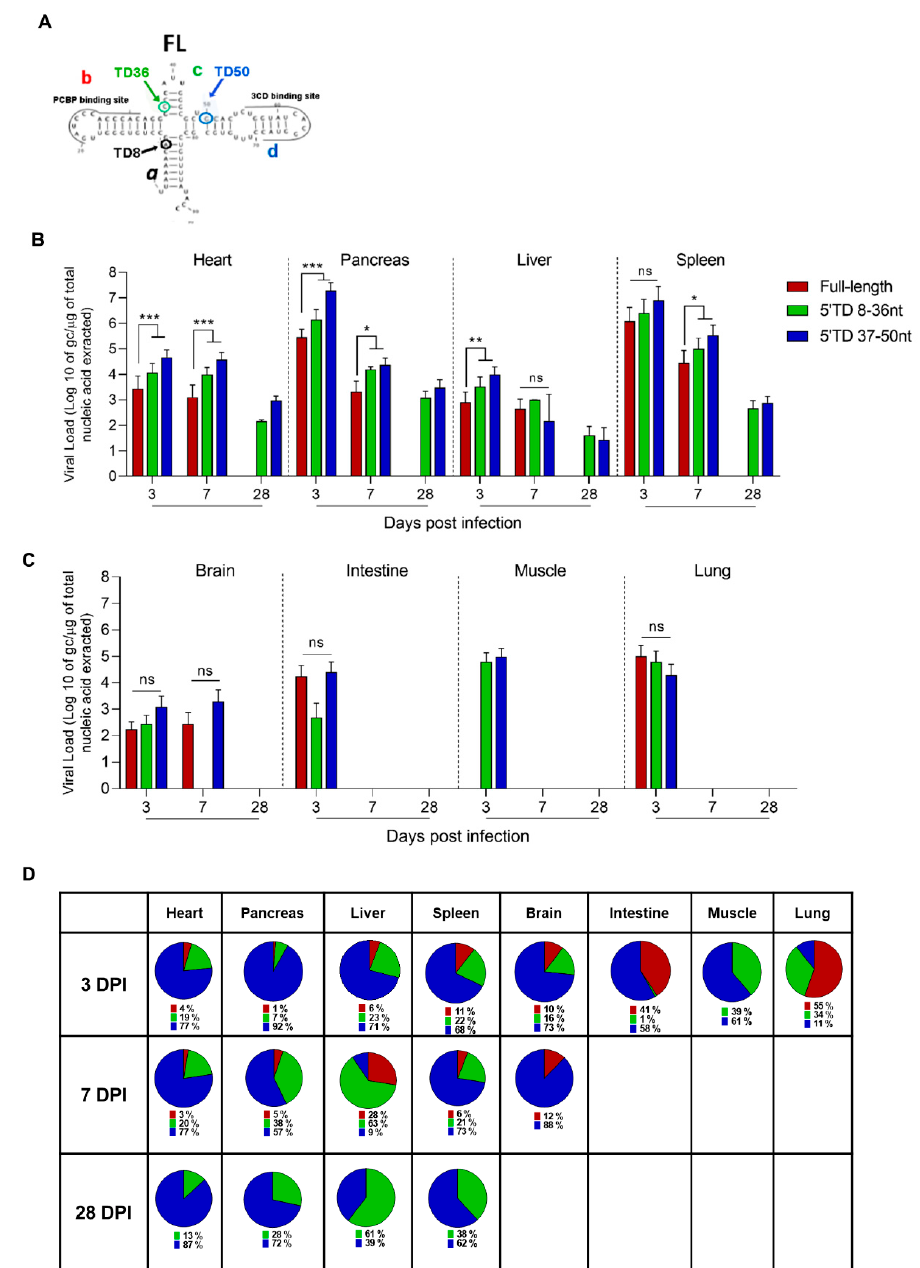
Figure 2. Emergence and maintenance of 5 ′ TD EV-B populations in organs of CVB3/28-infected mice. ( A ) Schematic representation of EV-B cloverleaf secondary structures with stem “a” and stem-loops “b”, “c”, and “d”. Schematic representations of deletions of 8, 36, and 50 nucleotides and its impact on cloverleaf secondary structures, loss of stem “a”, stem “a” plus stem-loop “b”, and loss of stem “a” and stem-loops “b-c”, respectively. ( B , C ) EV-B FL and 5 (cid:48) TD respective viral loads were measured using a RACE-PCR method associated with a micro-electrophoresis (Agilent ® ) in organs of CVB3/28- infected mice ( n = 8 to 10 in B; n = 3 to 6 in) ( C ). Data represents mean + SEM (Mann–Whitney U test; *: p < 0.05; **: p < 0.01; ***: p < 0.001, ns: non-significant). ( D ) Schematic representation of full-length and 5 (cid:48) TD populations percentages. Data represents mean. TD: terminally